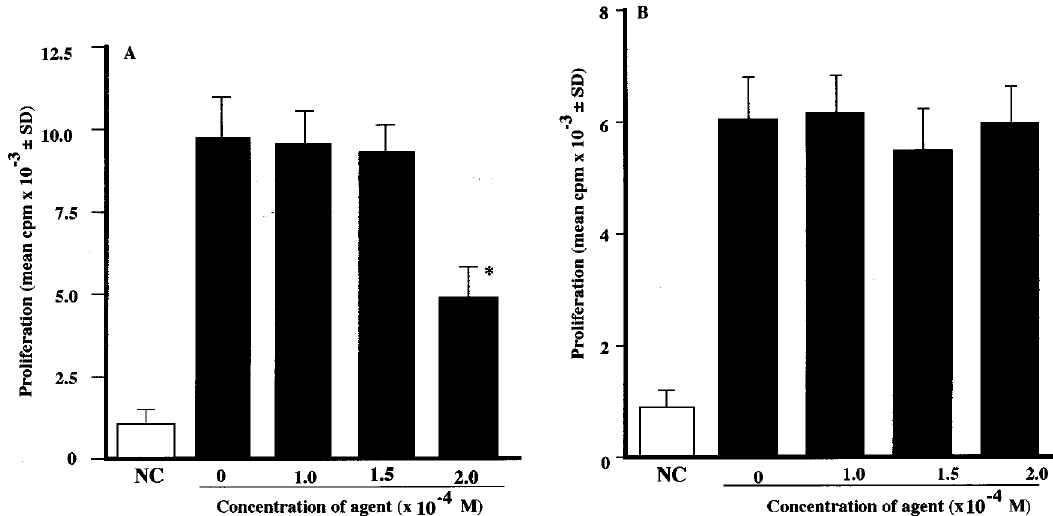
FIG. 3. Influence of disodium cromoglycate (DSCG) on proliferative response of lymphocytes in vitro . BALB/c mice were immunized by intraperitoneal injection with 8.0 m g haemocyanin absorbed to 4.0mg aluminium hydroxide in a volume of 0.5ml. Spleen cells (1 ´ 10 5 cells/0.1ml) prepared from mice 10 days later were cultured in the presence of various concentrations of DSCG for 48h, which were stimulated with specific antigen (A). Splenic T cells were also cultured with immorbilized anti-CD3 « monoclonal antibody in the presence of various concentrations of DSCG for 48h (B). These cells were pulsed with 1.0 m Ci 3 H-thymidine for the last 8h of culture. The results were expressed as the mean±SD of five individual mice. NC: non-stimulated control. * P < 0.05, significantly different as compared with no